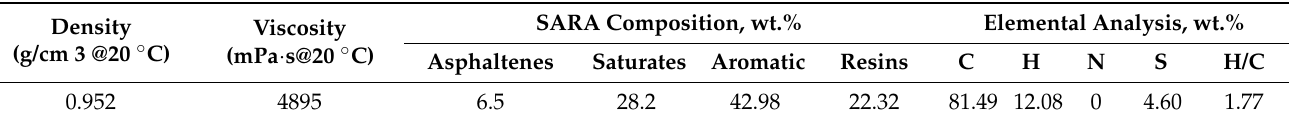
Table 3. Basic properties, SARA fractions and elemental analysis of Ashalcha heavy